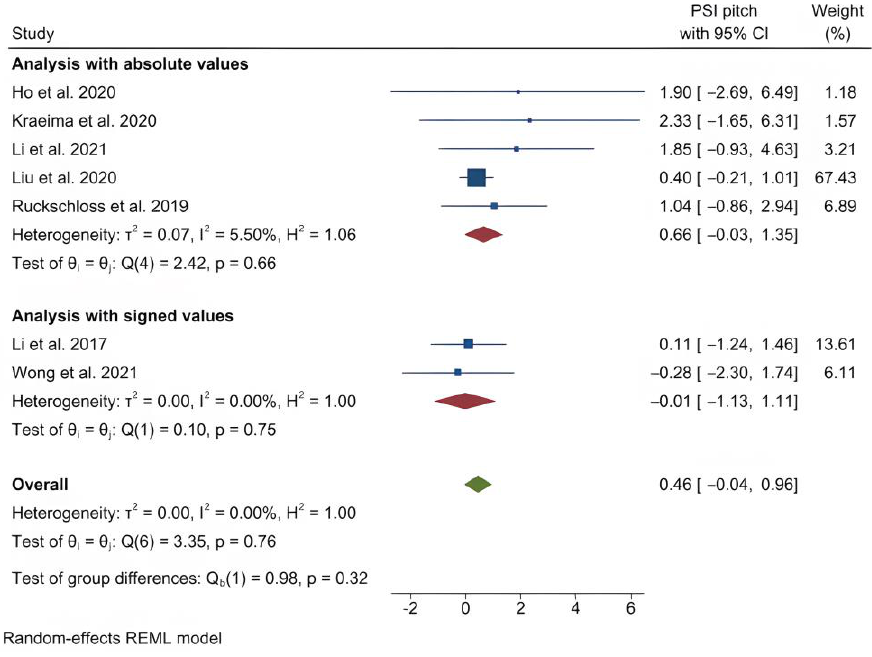
Figure 6. Forest plot showing mean pitch deviation.